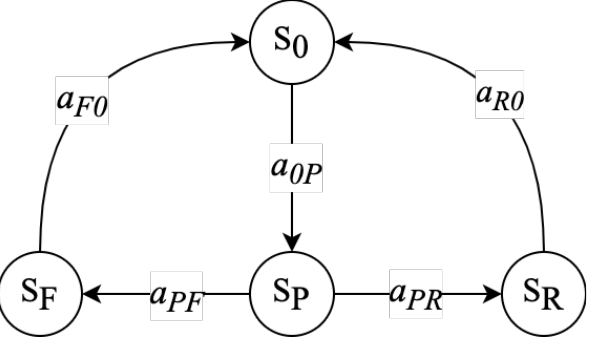
Figure 1. Graph of states and transitions of the primary software aging and rejuvenation model [22].